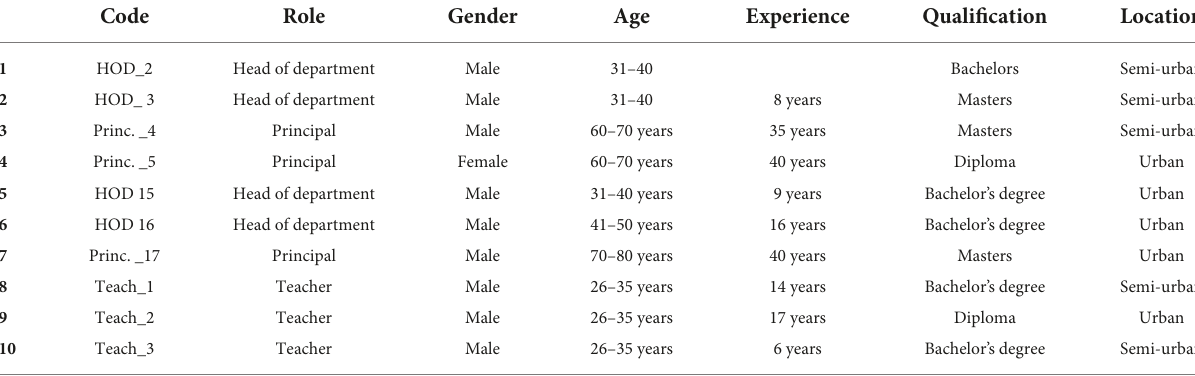
TABLE 2 Detailed profile of study